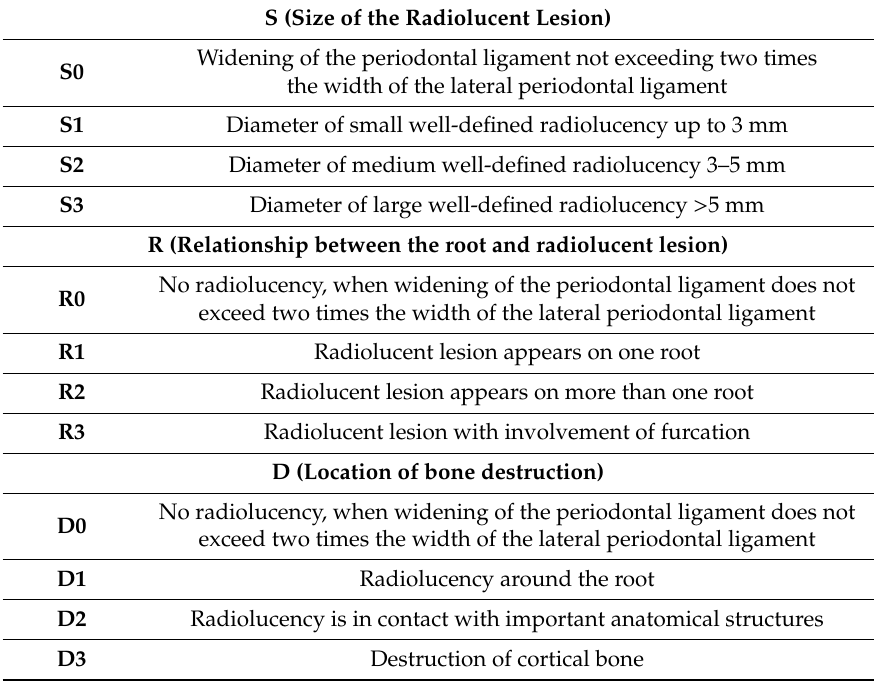
Table 1. Complex Periapical Index (COPI) evaluation